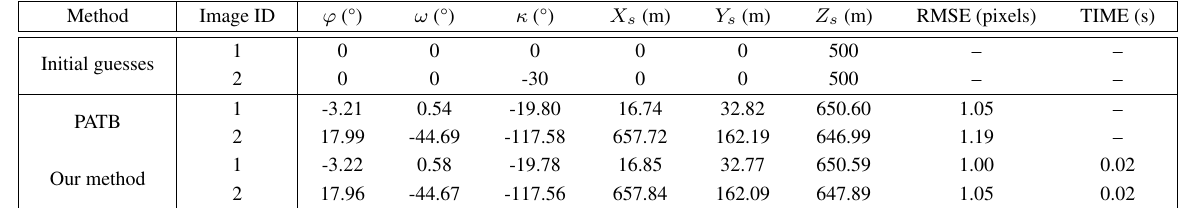
Table 2. The image orientation results on two large-scale real images.